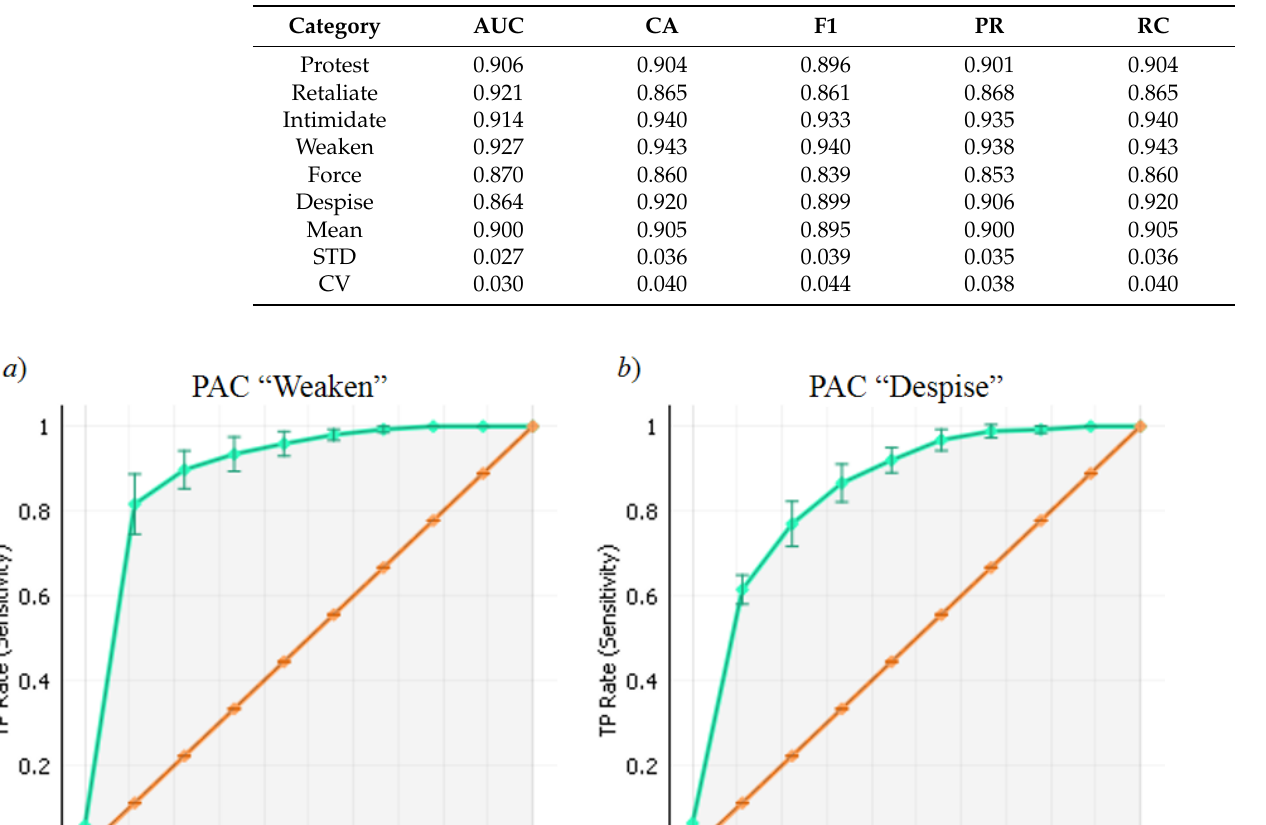
Table 5. XGB scores for predicting each class using OvR classification.